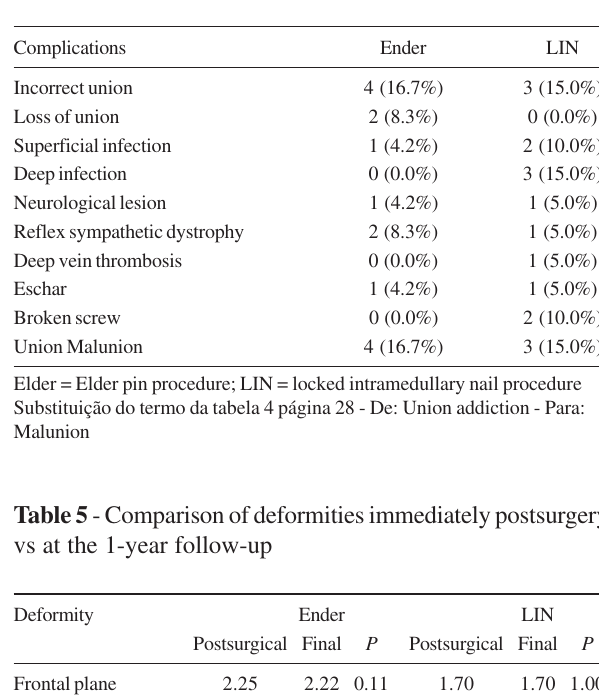
Table 4 - Complications